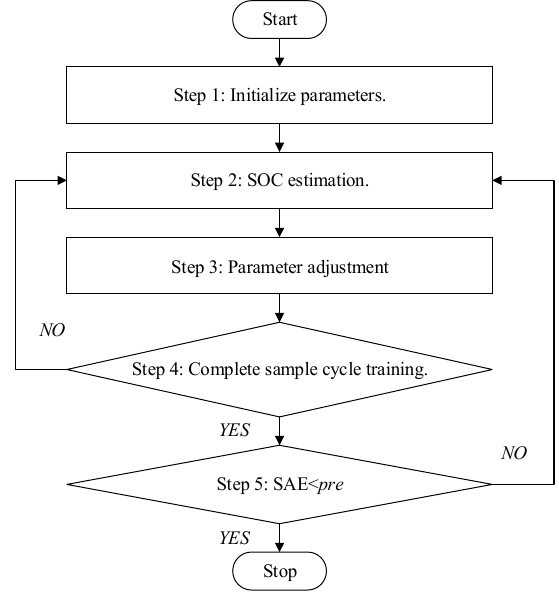
Figure 4. PTCFNN training process.